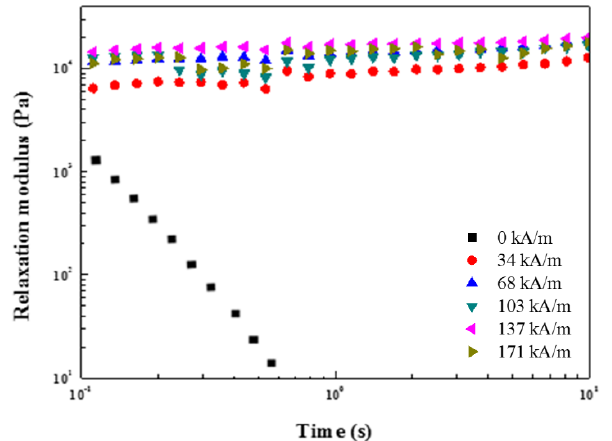
Figure 17. G(t) of the ZnFe 2 O 4 /PMA-based MR fluid analyzed from G’ and G” in the frequency sweep measurement.